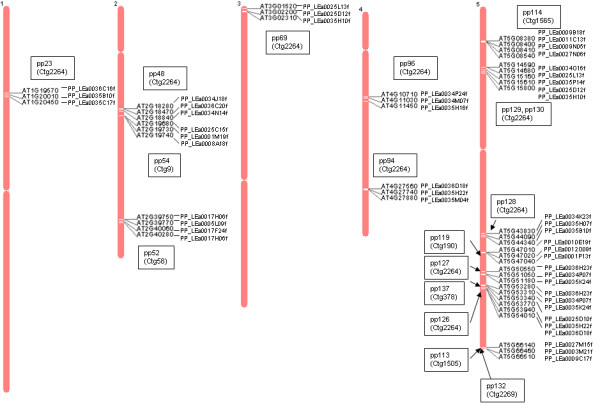
Conserved syntenic regions with three or more gene pairs between Arabidopsis genome and EST-anchored peach BAC contigs.